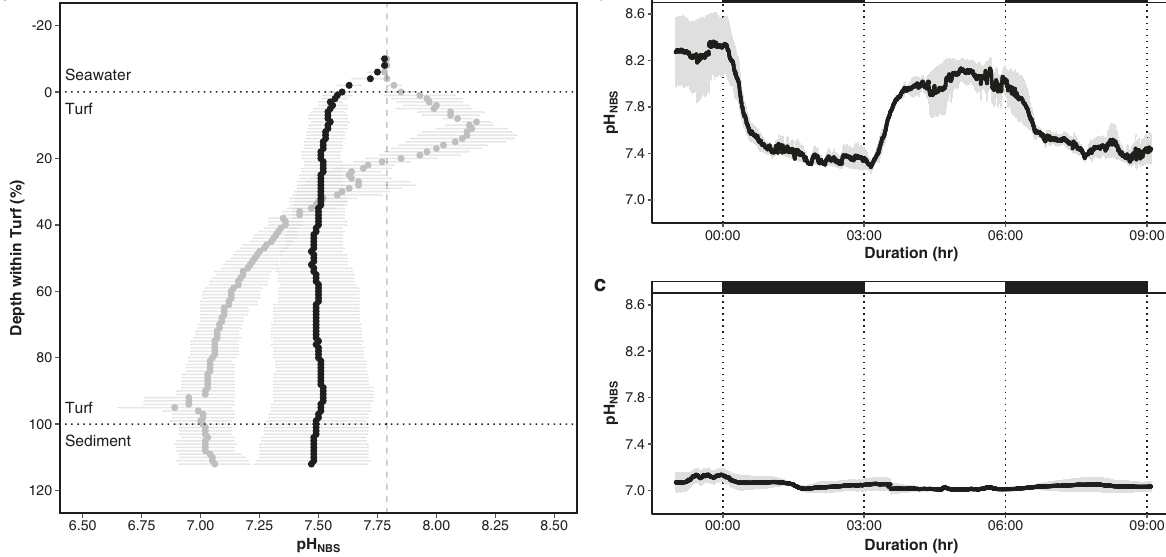
sediment below the turf algal assemblage the light-dark shift had across the light and dark periods (Fig. 5c).